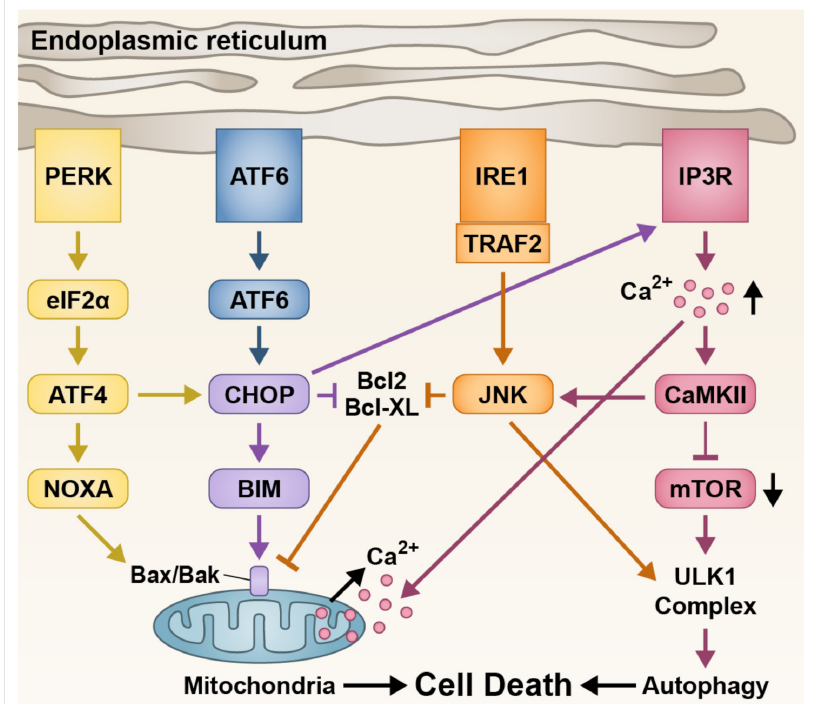
Figure 3. ER stress pathways through activation of transmembrane ER proteins to induce cell death. PERK and ATF6 triggers CHOP activation, blocking pro-survival proteins BCL2 and BCL-XL, and inducing mitochondria-mediated cell death. CHOP can also act on IP3R to release Ca 2+ from the ER, leading to further mitochondrial dysfunction and autophagy-mediated cell death. IRE1 interacts with TRAF2 to activate the JNK pathway, blocking pro-survival proteins and increasing